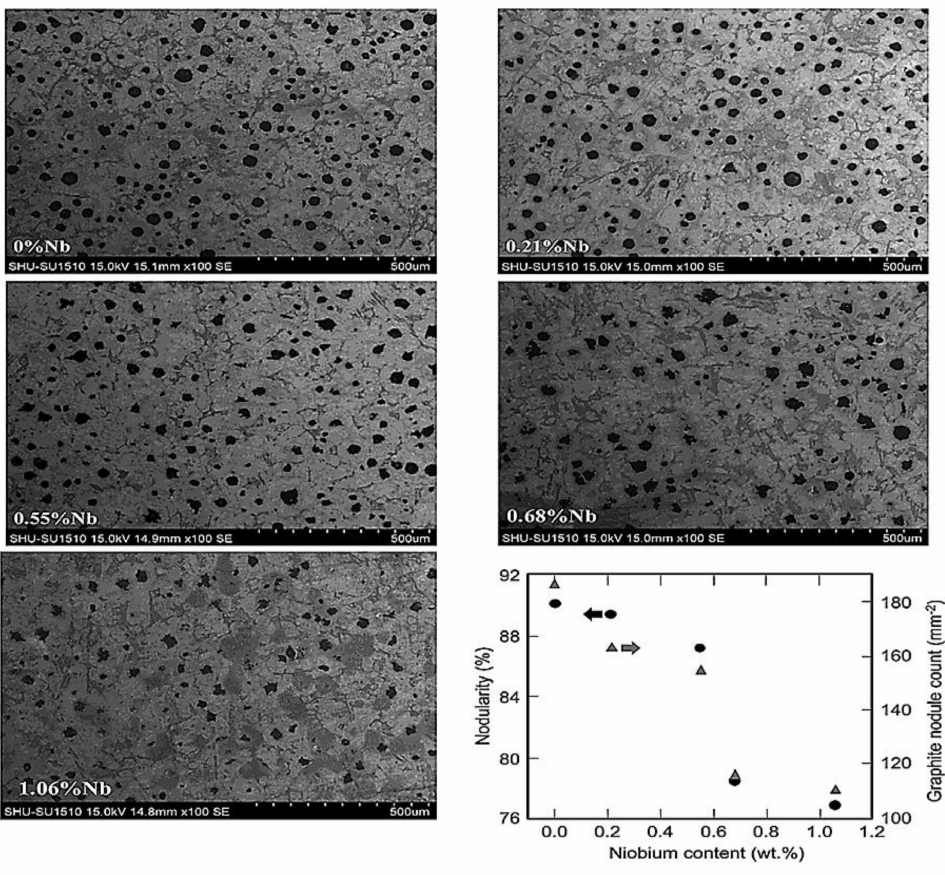
Figure 15. Scanning electron microscope images of graphite in as-cast ductile iron for varying niobium contents and quantitative evaluation of the nodularity and nodule count